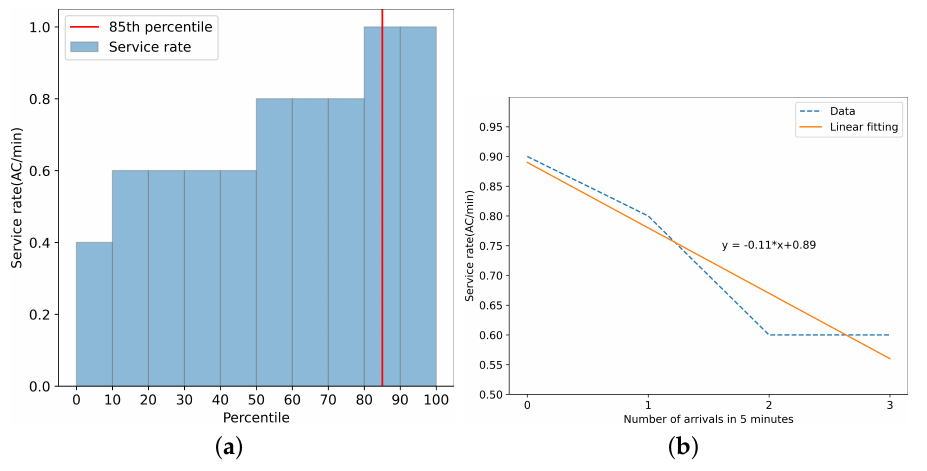
Figure 4. Service rate computation. ( a ) Average service rate (five minutes); ( b ) Service rate